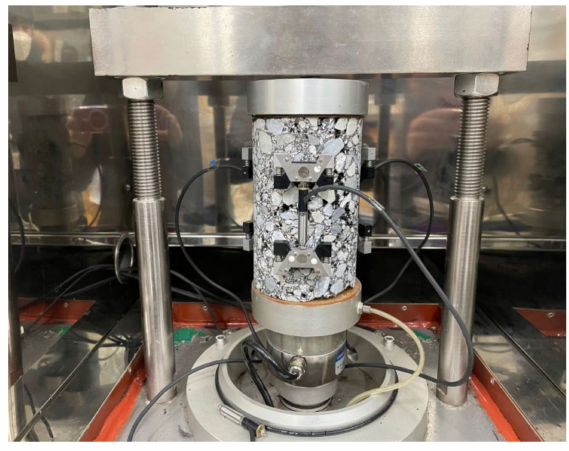
Figure 6. Dynamic modulus